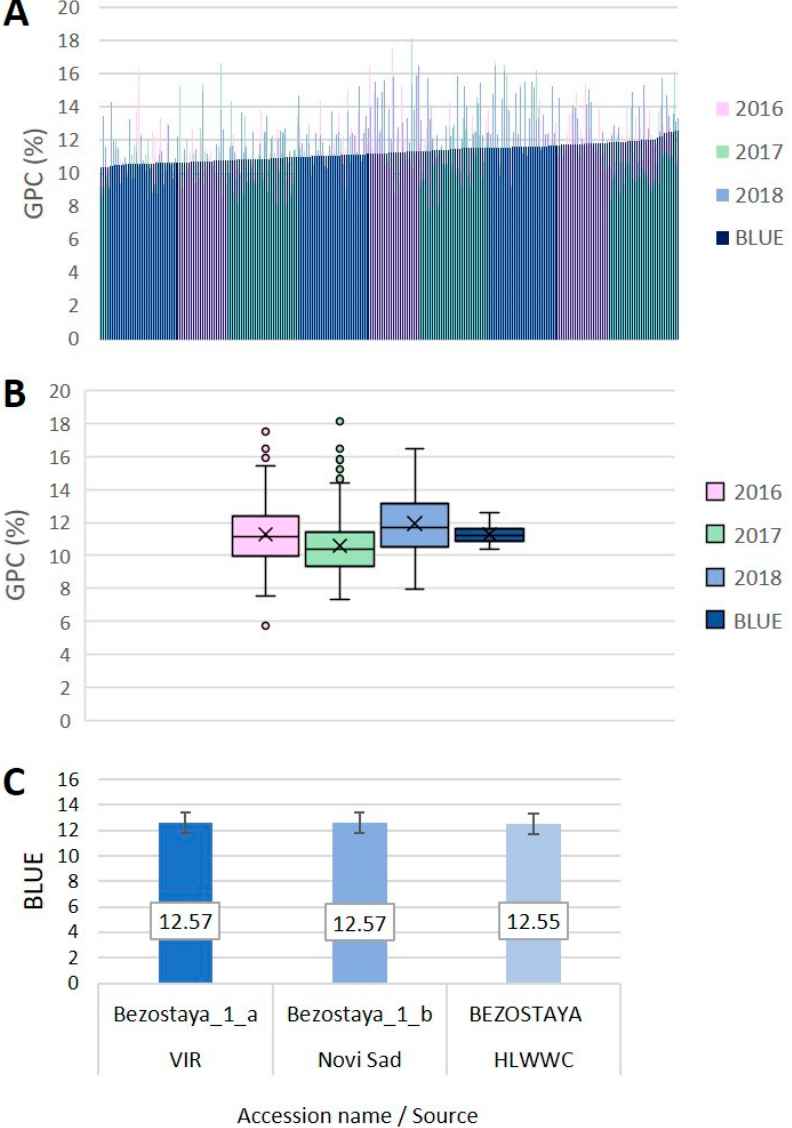
Figure 1. ( A ) Distribution of 255 bread wheat accessions from 27 countries for grain protein content (GPC, %); ( B ) box-plots of GPC (%) in three growing seasons (2016, 2017, 2018), and best linear unbiased estimates (BLUEs); ( C ) top three best accessions based on BLUEs.